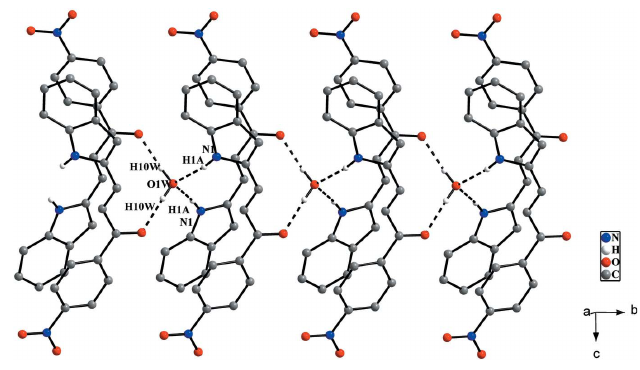
Figure 2 The crystal packing of the title compound along the b axis showing the O—H (cid:2)(cid:2)(cid:2) O and N—H (cid:2)(cid:2)(cid:2) O hydrogen bonds as dotted lines.